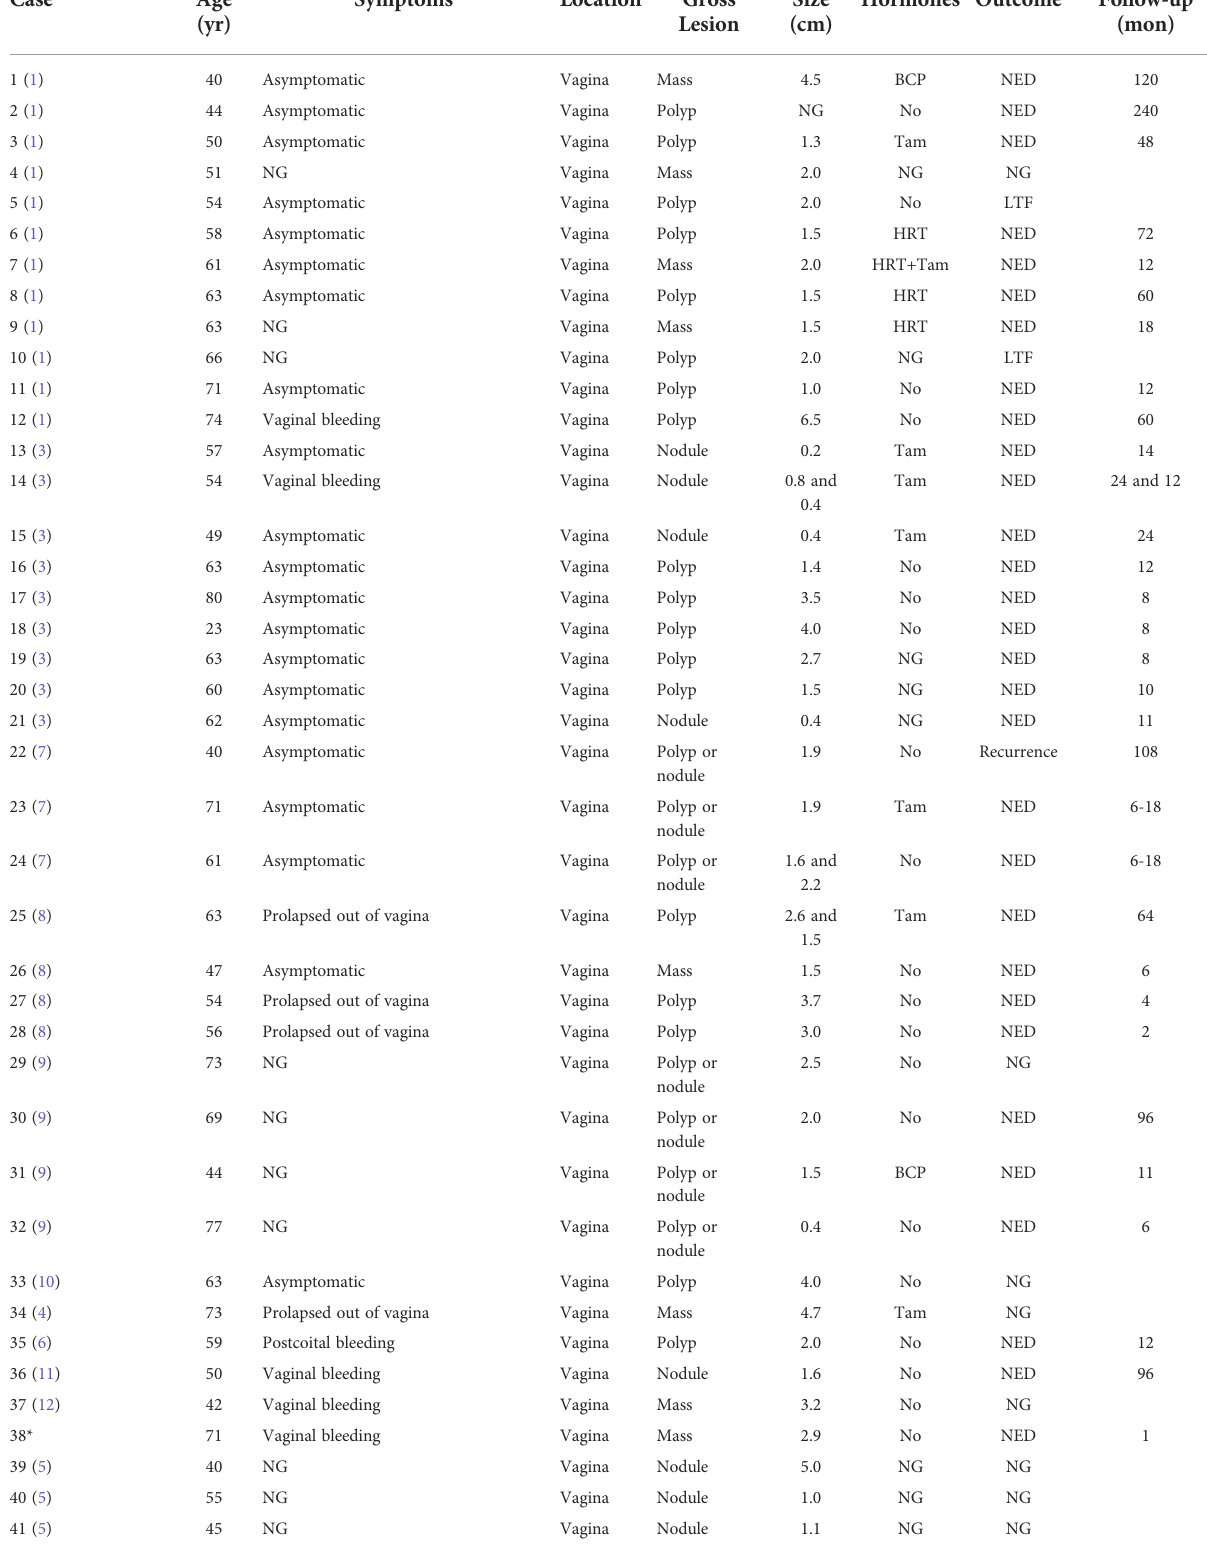
TABLE 1 Cases of super fi cial myo fi broblastoma of the lower female genital tract in the English language